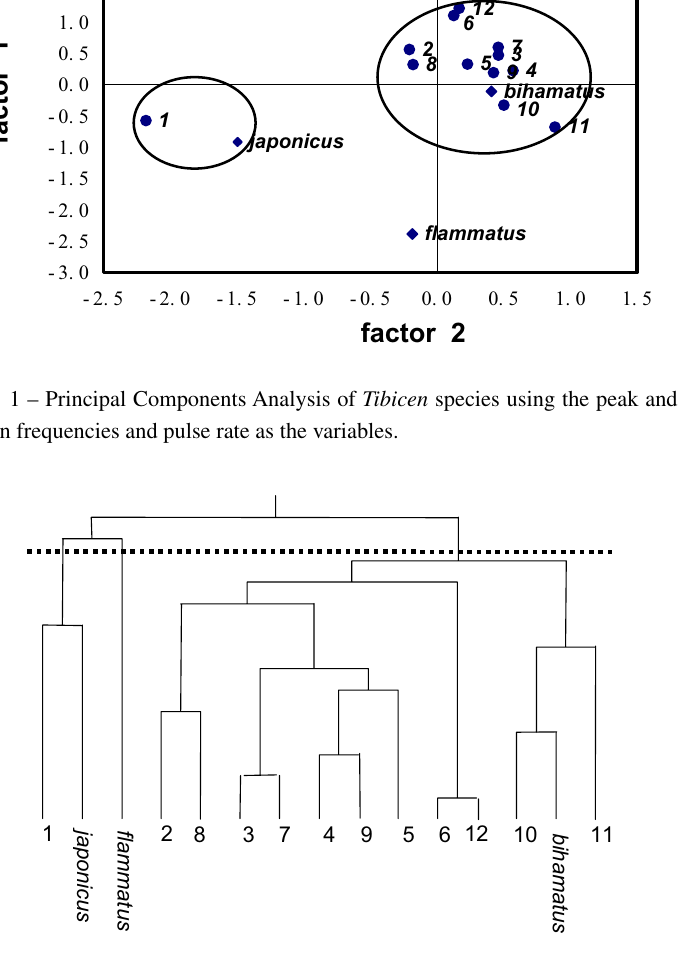
Fig. 2 – Dendrogram of the Tibicen species. The cluster analysis of the PCA scores clearly separated T. bihamatus , T. japonicus and T. flammatus from each other, and grouped the samples as they are expected to